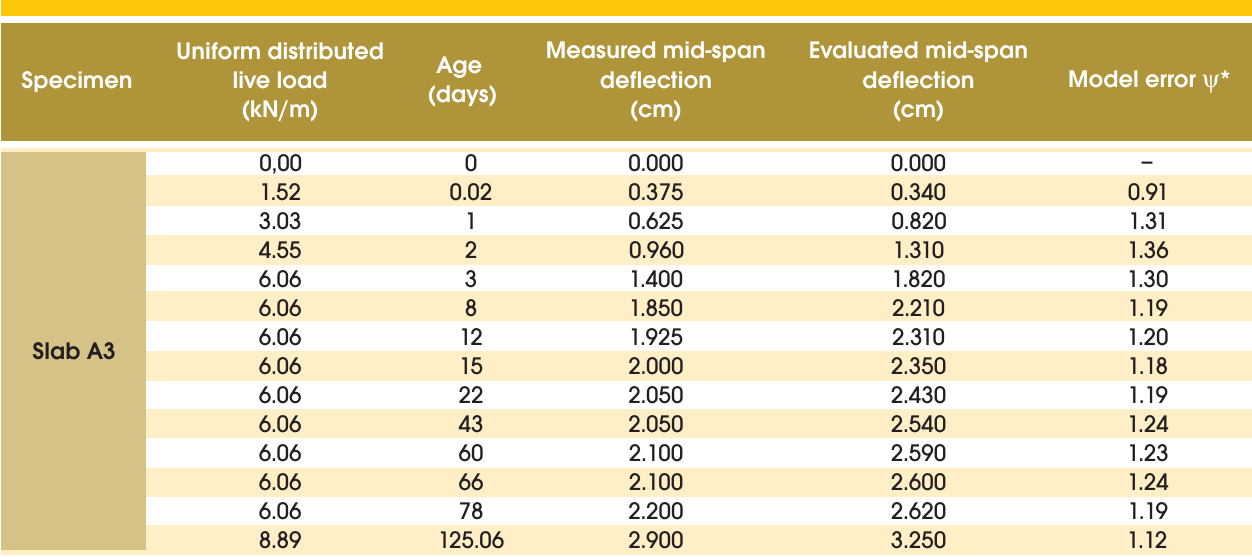
Table 2 – Results for slabs of Series 1 (continuation)